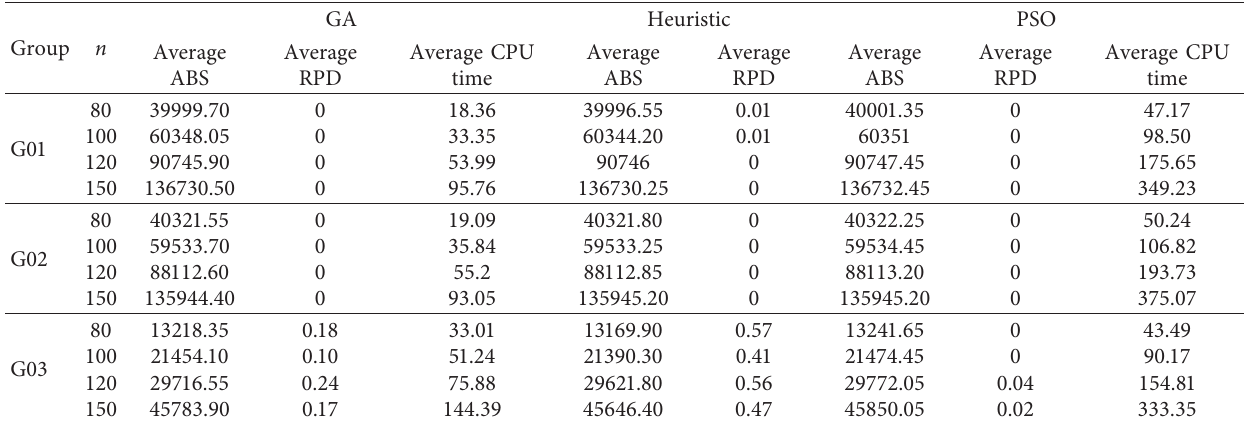
Table 3: Comparison of algorithms for LPP problem in large problem